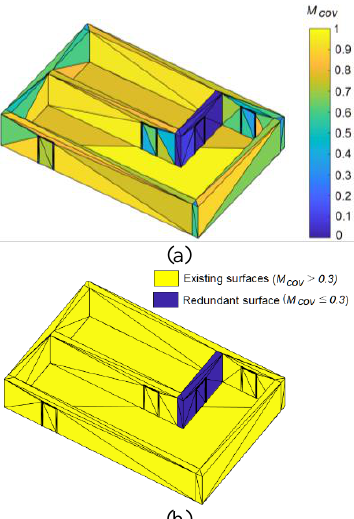
Figure 5. Comparison results of the synthetic dataset: (a) the BIM with surfaces colorized according to the coverage 𝑀 𝑐𝑜𝑣 ; (b) the BIM with the location of redundant elements (blue) and existing surfaces (yellow).